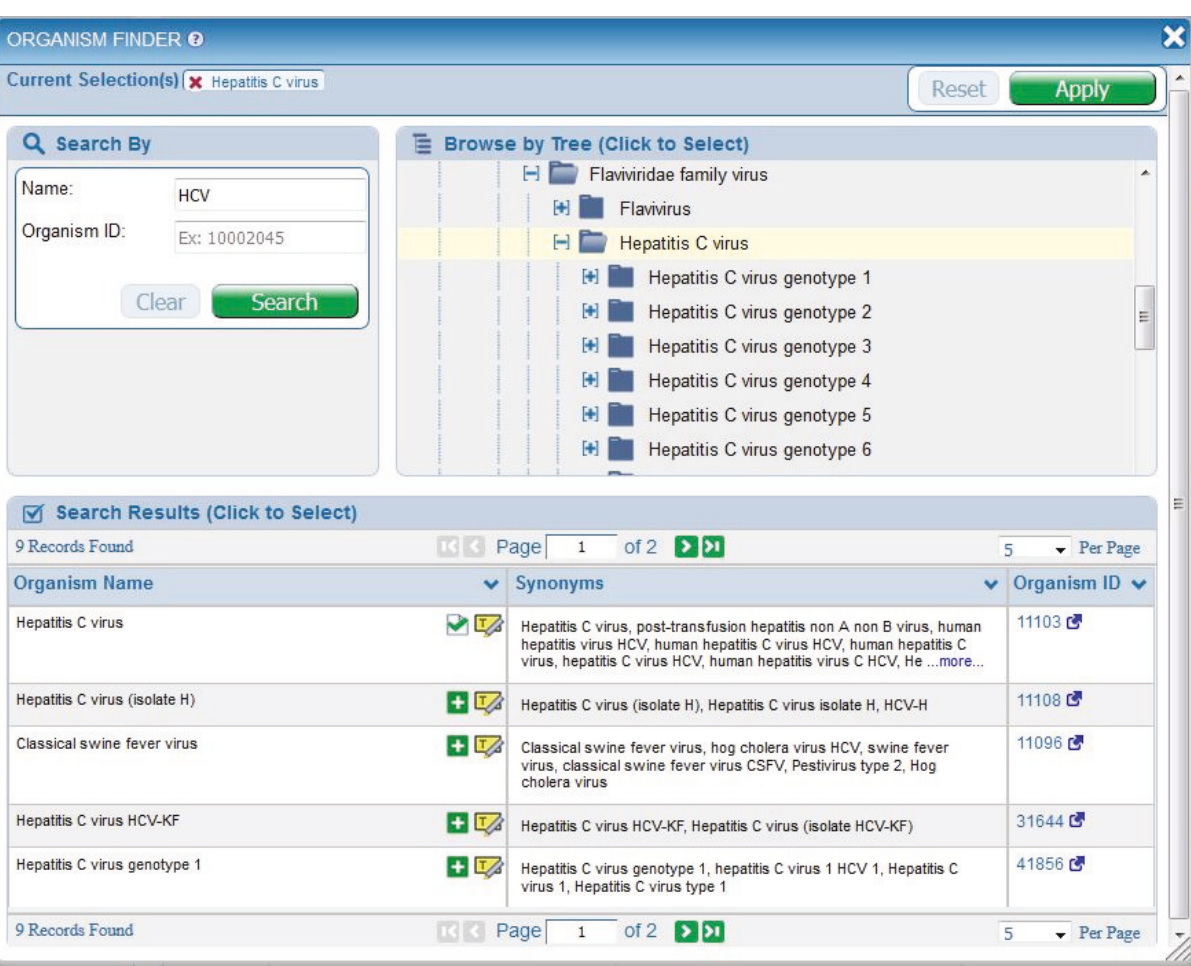
Figure 3: The Organism Finder can be used to select the search criteria for the epitope source organism. A similar fi nder is available for selecting the host